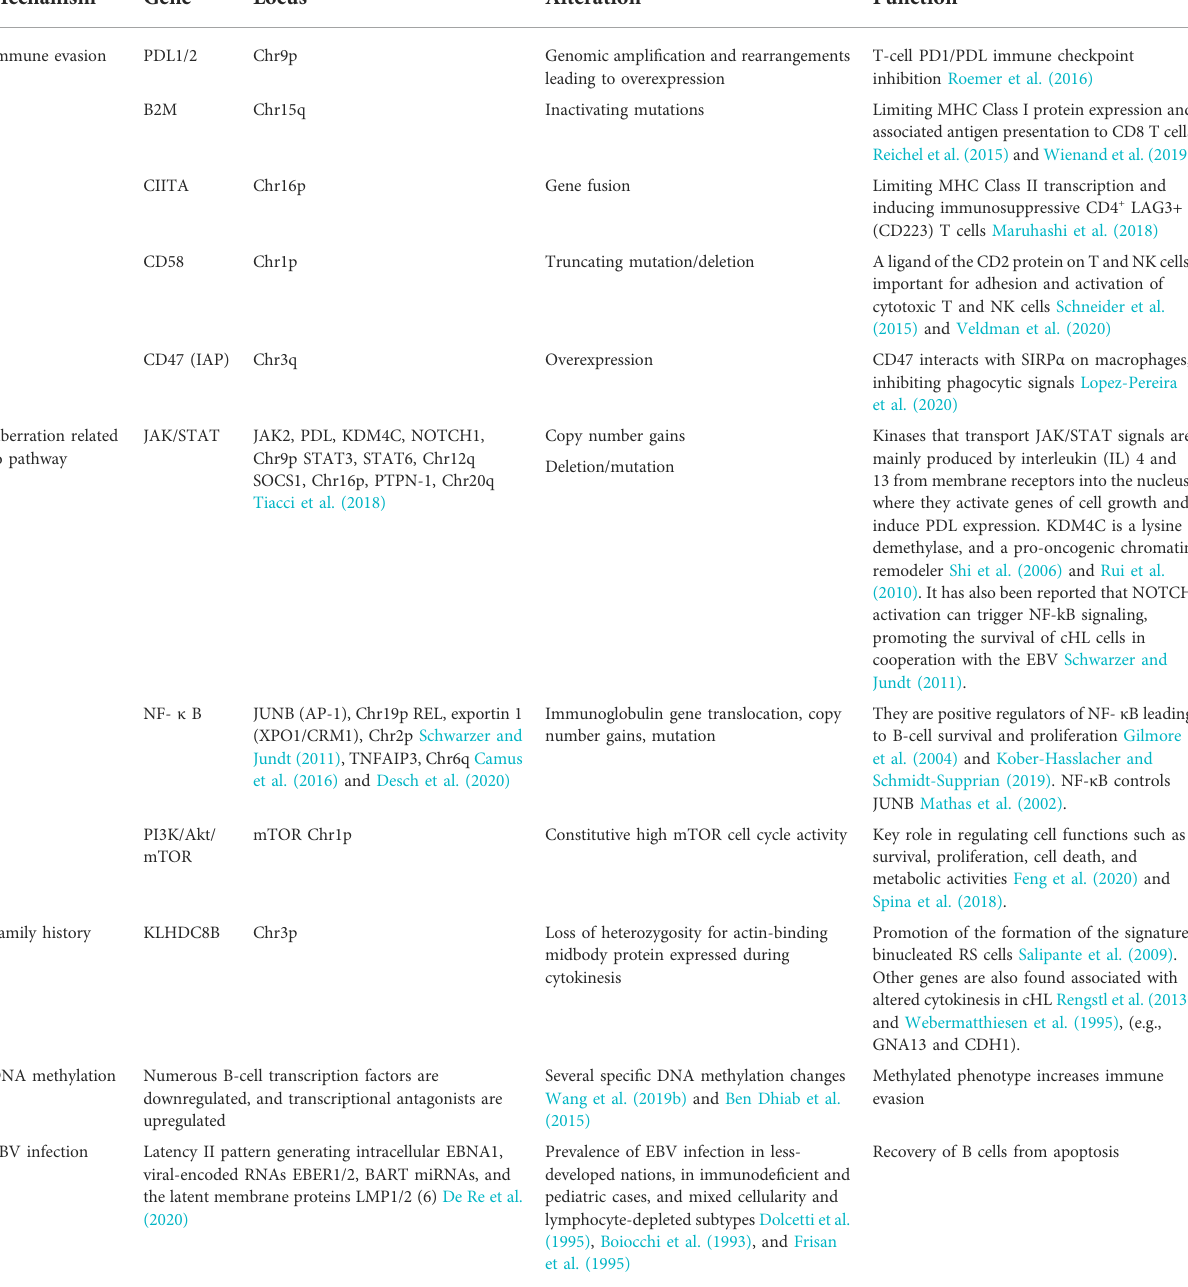
TABLE 1 Known genetic aberrations in HRS